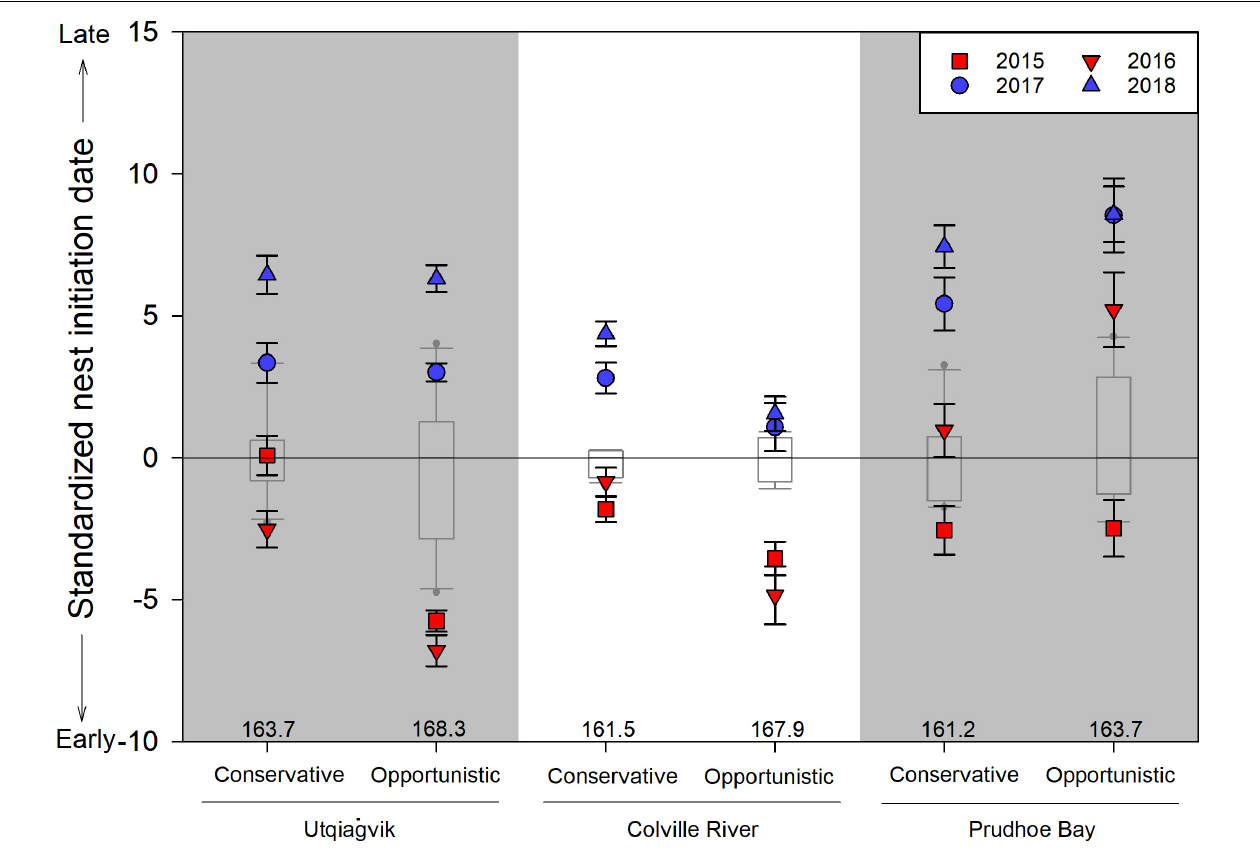
FIGURE 4 | Standardized shorebird nest initiation dates (mean ± SE) by conservative and opportunistic reproductive strategies in 2015–2018 in relation to long-term values (i.e., Utqia˙gvik: 2005–2014; Colville River: 2011–2014; Prudhoe Bay: 2005–2014). Data are standardized for each year and reproductive strategy separately by subtracting from them the long-term median value (median values listed above x-axis); box plots represent the 25 th and 75 th percentiles with error bars at the 10 th and 90 th percentiles and the line crossing at the median value. Early springs (i.e., 2015 and 2016) are illustrated in red while late springs (i.e., 2017 and 2018) are illustrated in blue. Julian date 150 = 30 May (29 May in leap years). See Table 2 for species assignments to reproductive strategies and sample